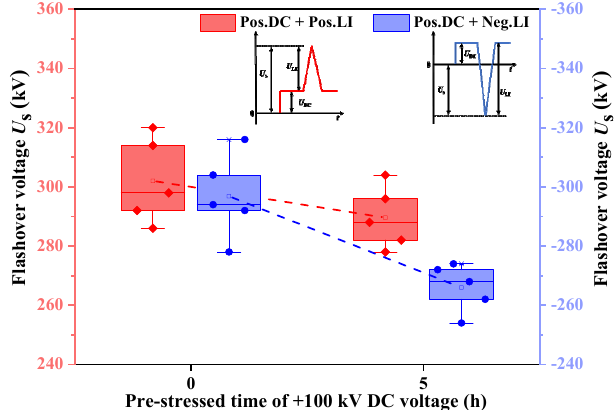
Figure 9. Relationship between flashover voltage of tri–post epoxy insulator and pre–stressed time of +100 kV DC voltage.